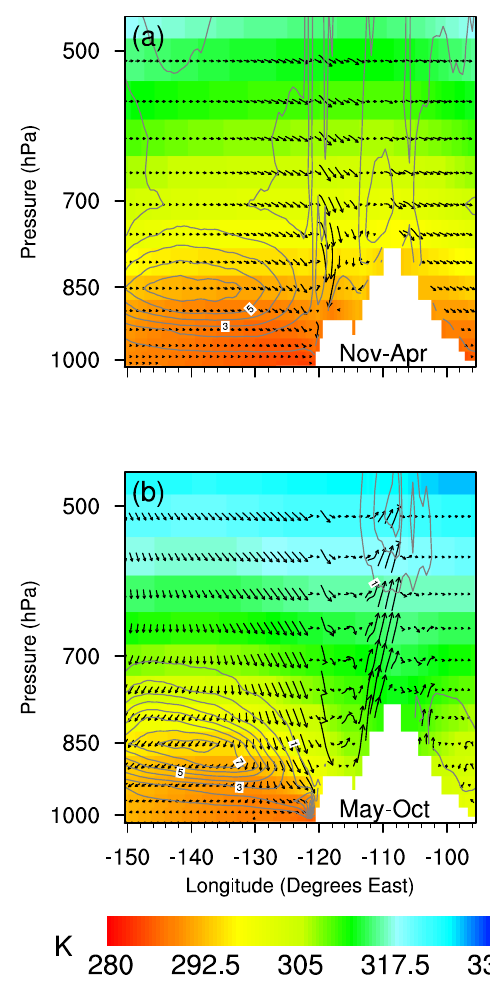
Fig. 10. UW run climatology (December 1984–November 2009) for the wet season ( a ; November–April) and the dry season ( b ; May– October), along a longitudinal transect on the 35 ◦ N parallel (shown in Fig. 1). The colors show the potential temperature, the gray con- tours show the liquid water mixing ratio (in cgkg − 1 ), and the vec- tors depict the air flow pattern. The vertical velocity is scaled such that its average is equal to the average zonal velocity to emphasize the vertical